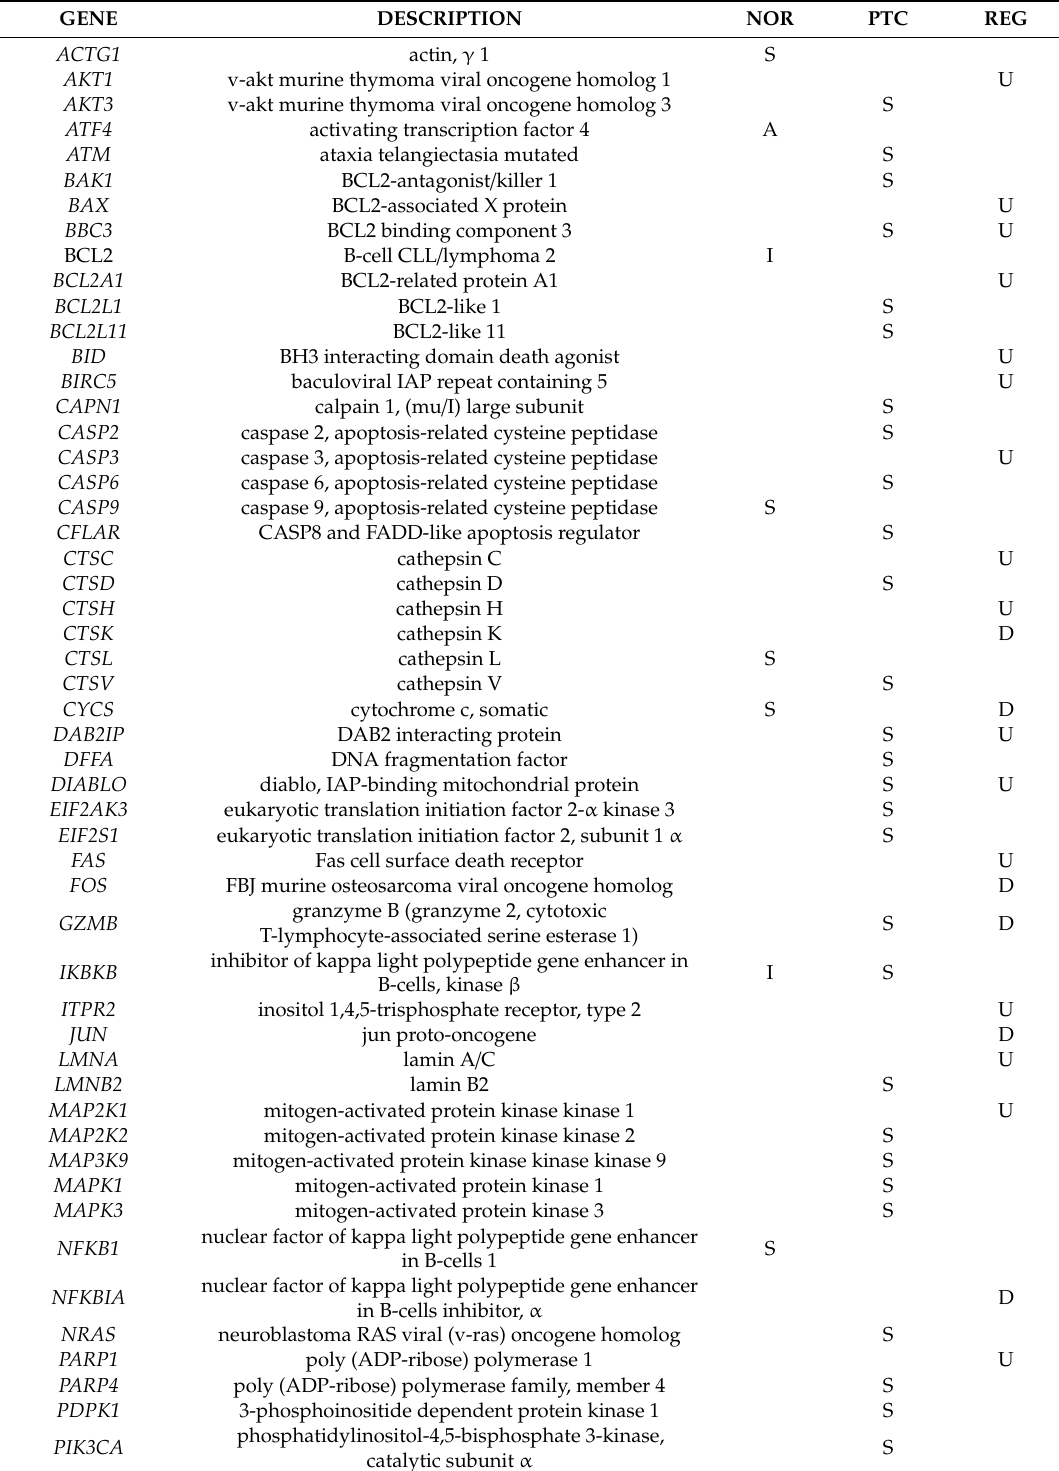
Table 1. Apoptosis genes that are significantly up(U) / down(D) regulated in PTC with respect to NOR or / and significantly synergistically (S) / antagonistically (A) / independently (I) expressed with SPINT2 in NOR or / and